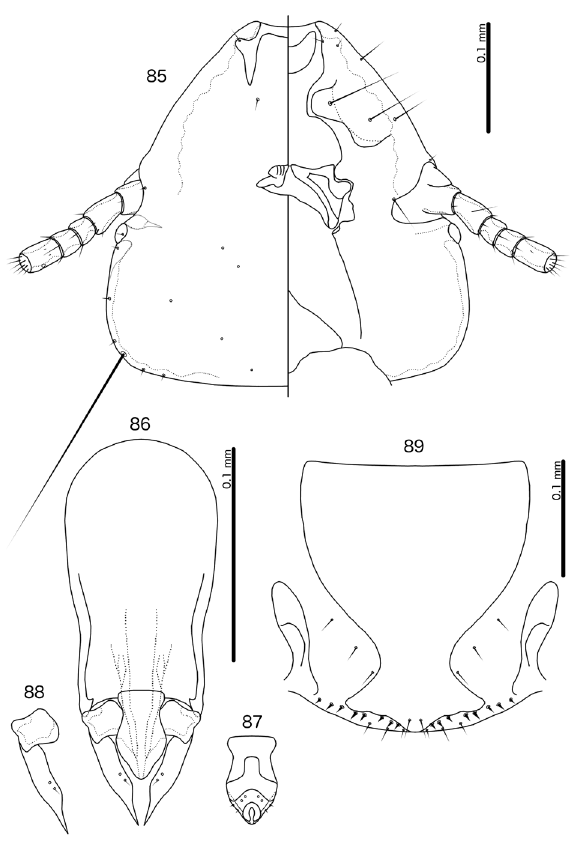
Figures 85–89. Guimaraesiella lais (Giebel, 1874) ex Luscinia megarhynchos (Brehm, 1831) 85 Male head, dorsal and ventral views 86 Male genitalia, dorsal view 87 Male mesosome, ven- tral view 88 Male paramere, dorsal view 89 Female subgenital plate and vulval margin, ventral